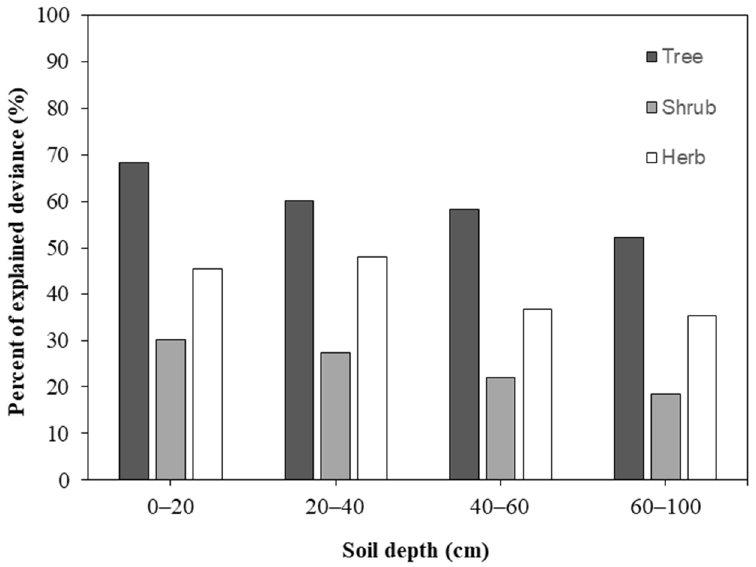
Figure 4. Contribution of environmental factors to plant β -diversity at different soil depths.